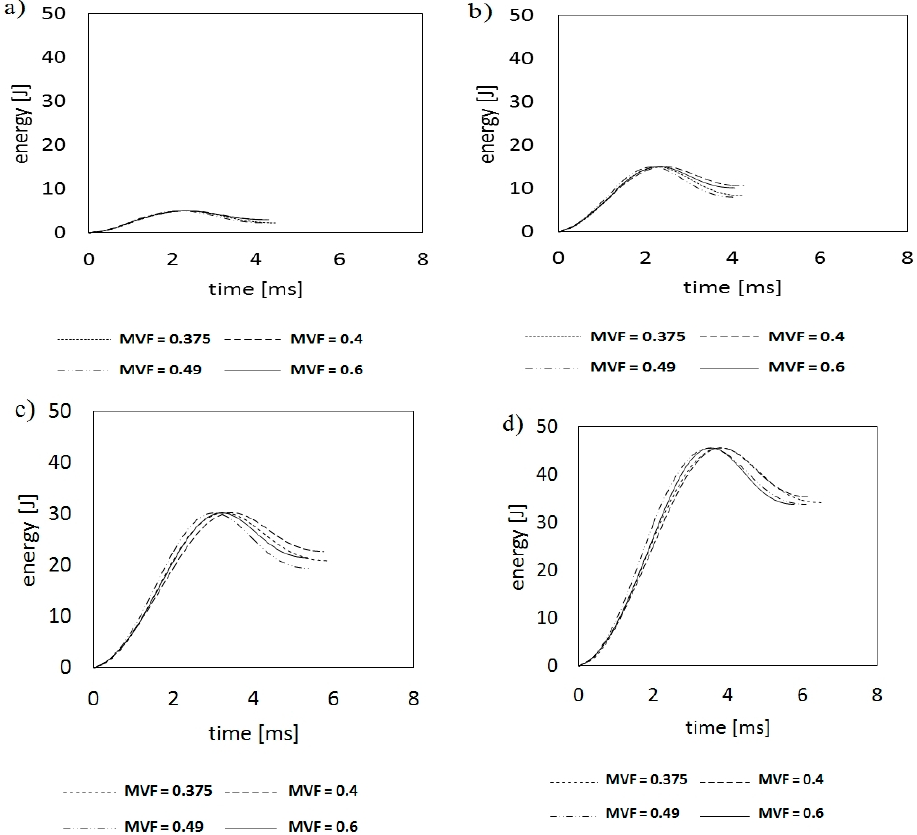
Figure 5. The curves represented the energy absorption process in time of HTCL with various MVF after low-velocity impact with energy 5 J ( a ); 15 J ( b ); 30 J ( c ); and 45 J ( d